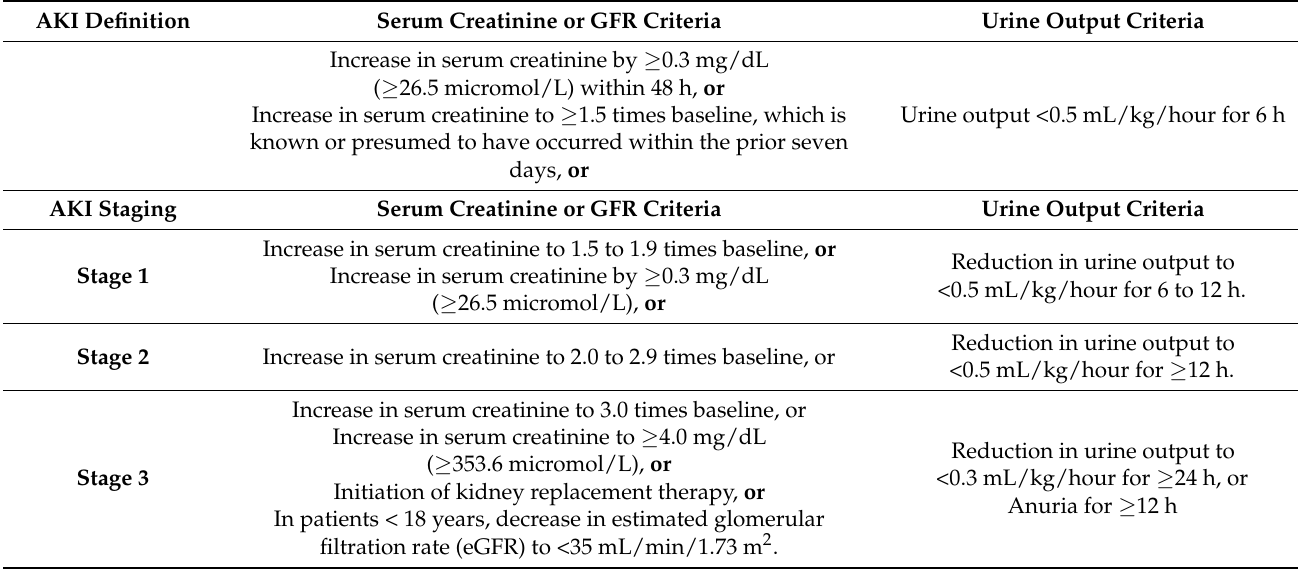
Table 1. Acute kidney injury (AKI) definition and